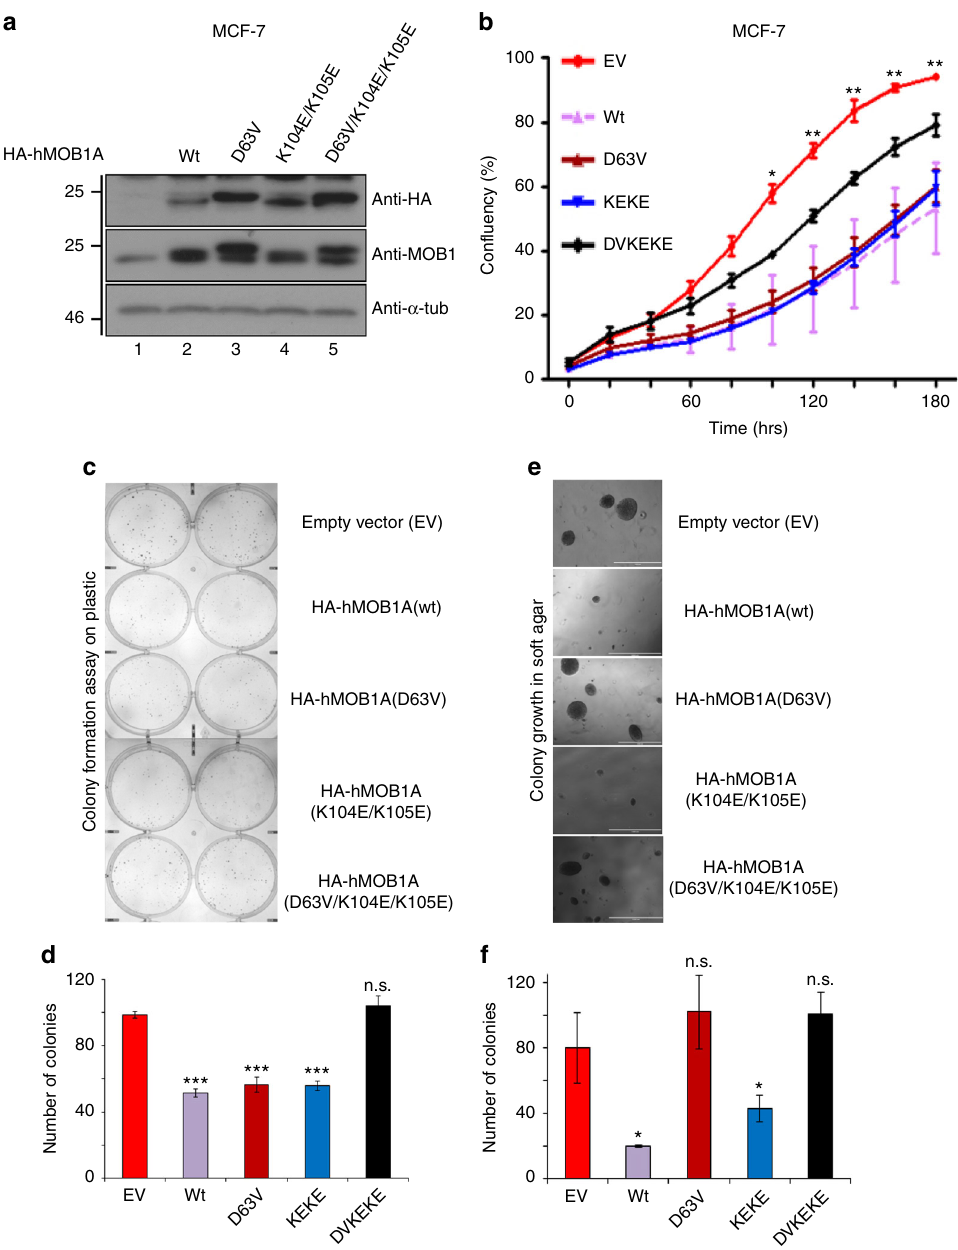
Fig. 4 MOB1 binding to LATS1/2 is required to suppress anchorage-independent growth of human cancer cells, while MOB1 binding to MST1/2 is dispensable. a Immunoblotting with indicated antibodies of cell lysates derived from MCF-7 human breast cancer cells stably expressing the indicated HA-MOB1 variants or empty vector ( EV ) as negative control in lane 1. Relative molecular weights are indicated. See Supplementary Fig. 19 for uncropped western blots. b Proliferation rates of attached MCF-7 cells stably expressing indicated HA-MOB1A variants. The average of three experiments performed in triplicates with three independent cell pools is shown ( n = 3). Statistically signi fi cant differences between EV and all MOB1 variant expressing cell pools are indicated ( *p < 0.05; * *p < 0.01). c Colony formation assays of the MCF-7 cells shown in a . Representative images are displayed. d Quanti fi cations of colony formation assays shown in c . The average of three experiments performed in duplicates with three independent cell pools is shown ( n = 3; ***p < 0.001; ns, not signi fi cant). P -values are: wt = 1.03E-05, DV = 5.42E-04, and KEKE = 1.95E-05 for comparison with EV cells. e Soft agar growth assays of the MCF-7 cells shown in a . Representative images are displayed. f Quanti fi cations of the soft agar growth assays shown in e . The average of three experiments performed in duplicates with three independent cell pools is shown ( n = 3; *p < 0.05; ns, not signi fi cant). P -values are: wt = 0.019 and KEKE = 0.04 for comparison with EV cells. wt , wild-type; DV D63V, KEKE K104E/K105E, DVKEKE